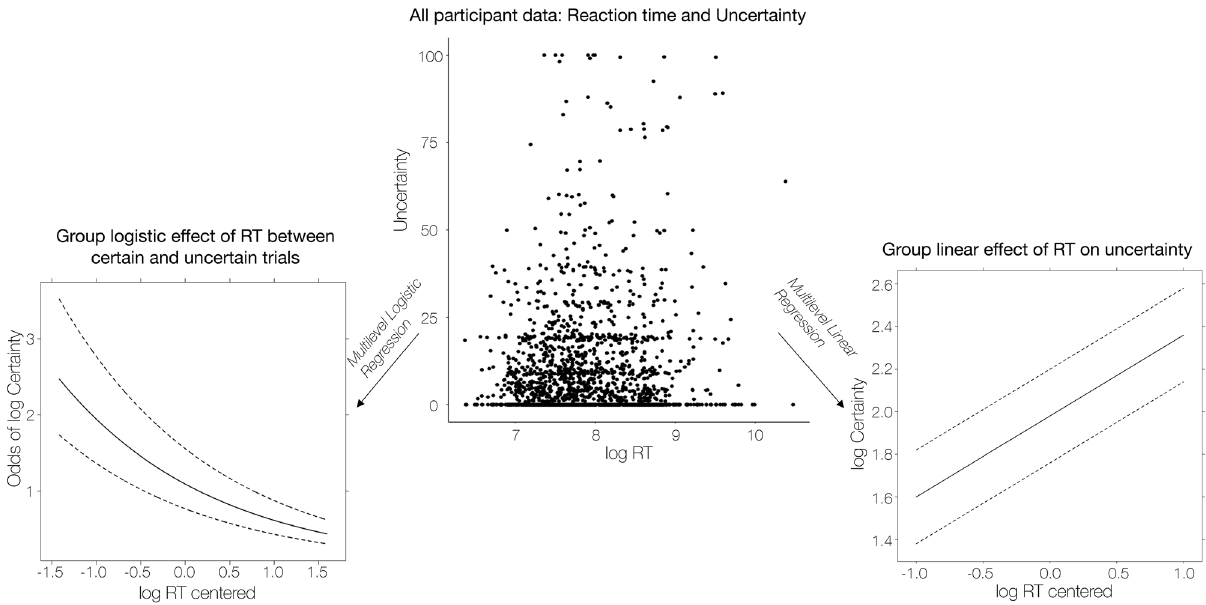
Figure 4. Associations between reaction time and uncertainty based on two-part multilevel model. Top : Confidence ratings were heavily weighted toward zero (i.e. complete certainty; see also Fig. 2). We therefore used a two-part multilevel model 43 to measure associations with uncertainty. The first (logistic) part classified trials into either ‘trials with uncertainty’ OR ‘trials with no uncertainty’ across all participant while the second (linear) part tested associations with variations in uncertainty within non-zero (i.e. uncertain) trials. Lower left: In the logistic part of the model, we evaluated whether fixations or reaction time (reaction time is shown) predicted the likelihood that a trial was rated with uncertainty or not across all participants. The solid black line represents the group estimate (exponentiated to transform from log odds to odds) and the dashed lines represents the confidence interval. Lower right: The linear part of the model evaluated whether fixations or reaction time (reaction time is shown) predict the variations in uncertainty within uncertain trials. The solid black line represents the group estimate and the dashed lines represents the confidence